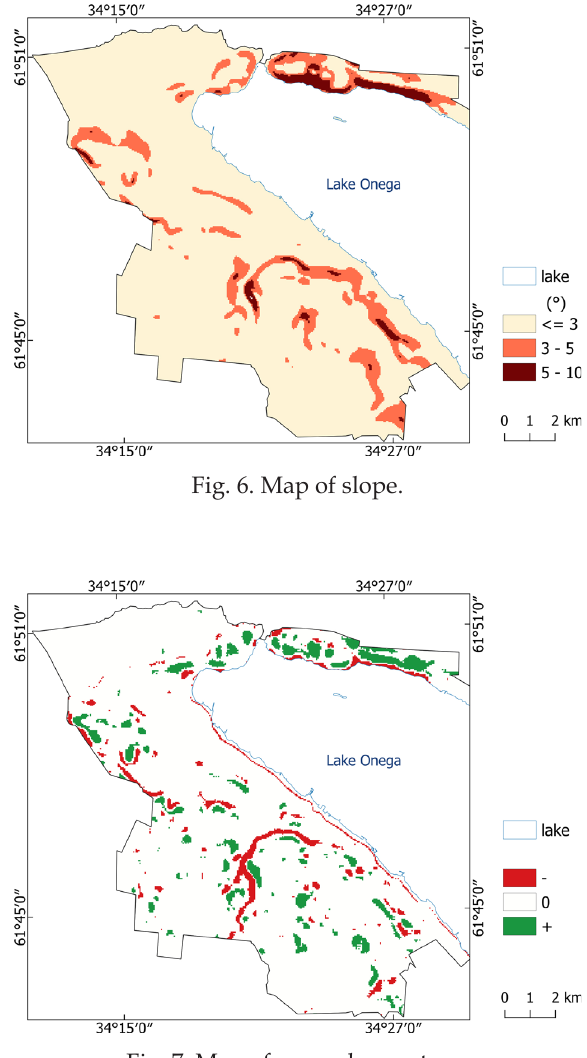
Fig. 7. Map of general curvature.